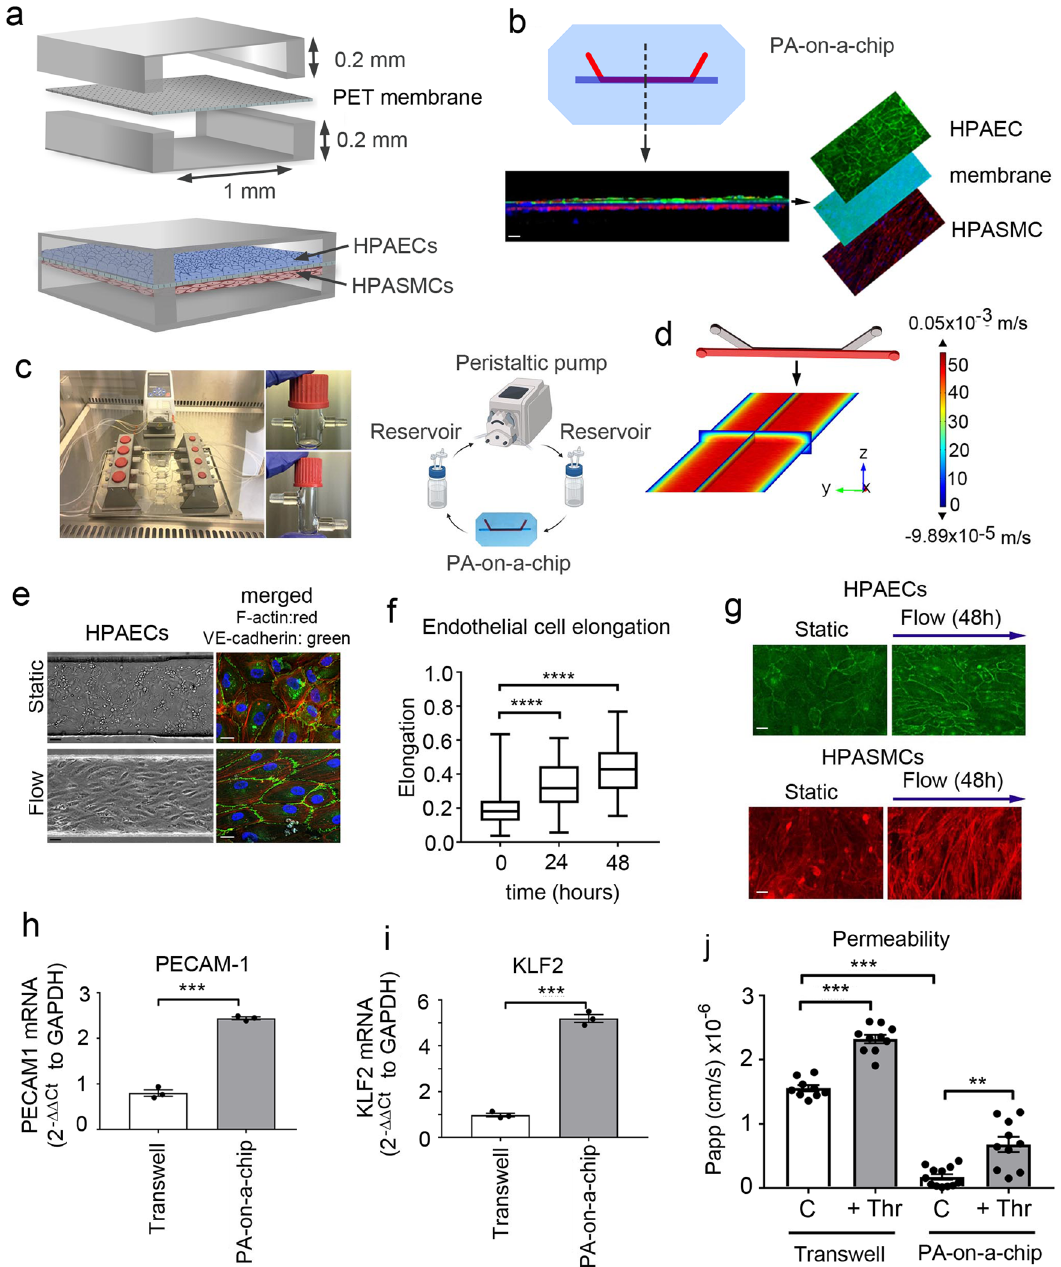
Fig. 1 Pulmonary artery-on-a-chip reproduces the functionality of a blood vessel. a Schematic diagram of the pulmonary artery-on-a-chip. b Z-section of endothelial-smooth muscle interface, fl uorescent confocal imaging. HPAECs (green: VE-cadherin), HPASMCs (red: α -smooth muscle actin). Bar = 10 µ m. c An image and a schematic diagram of the fl ow system set up comprising a peristaltic pump, media reservoirs and chips, perfused with culture medium at 6 dynes/cm 2 . d Fluid – structure interaction (velocity pro fi le) in the endothelial channel, COMSOL modelling. e Phase contract (left) and fl